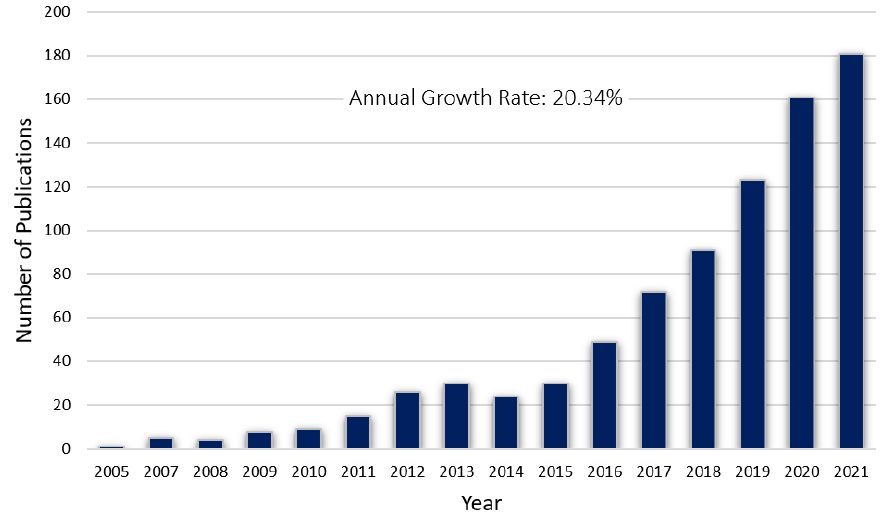
Figure 4. Number of all publications per year.